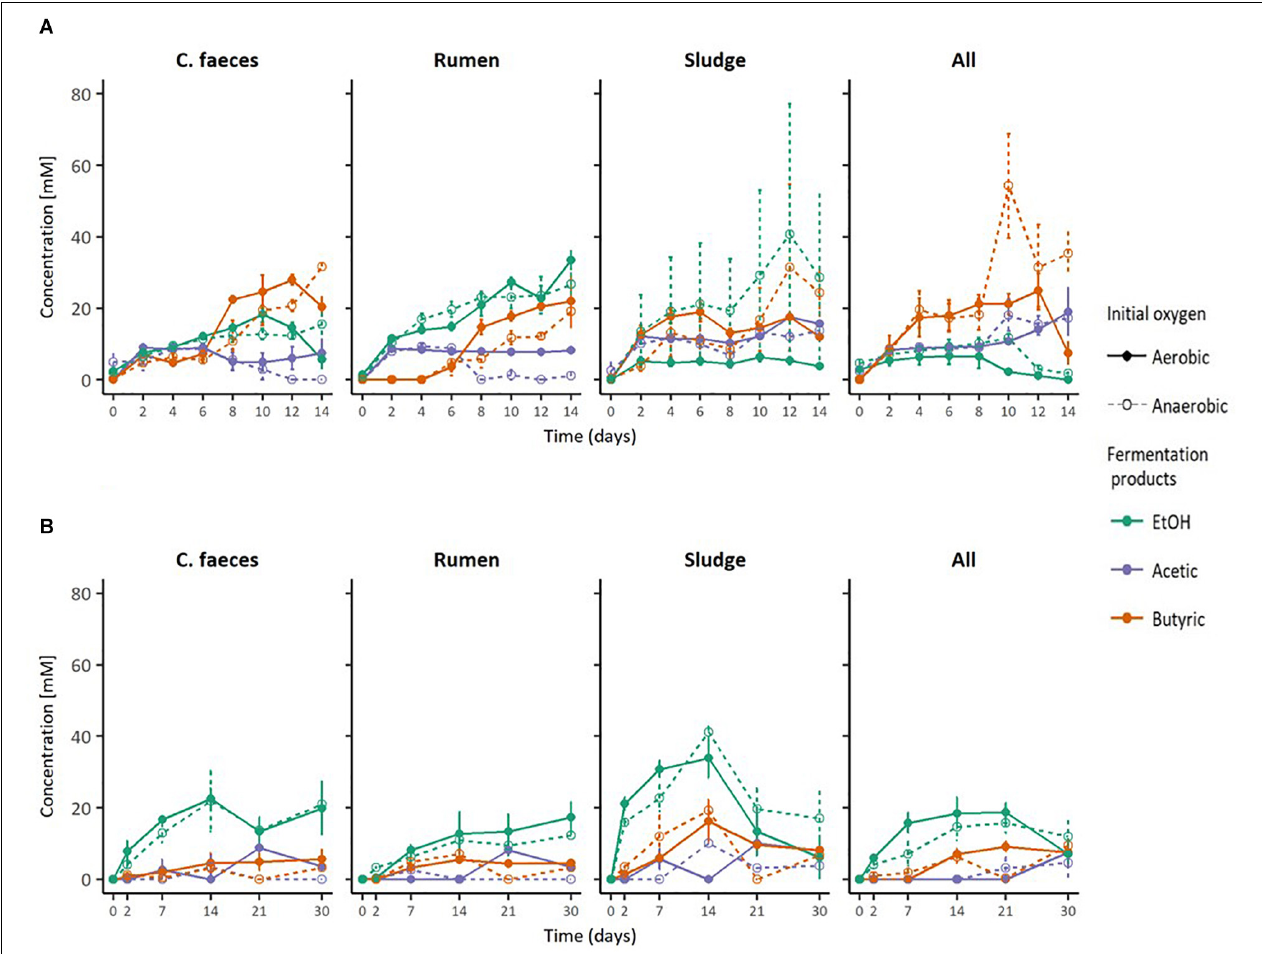
FIGURE 1 | Fermentation products by the different inocula tested under initial (A) neutral and (B) acidic pH. The error bars represent the standard error of the mean (SE), n =